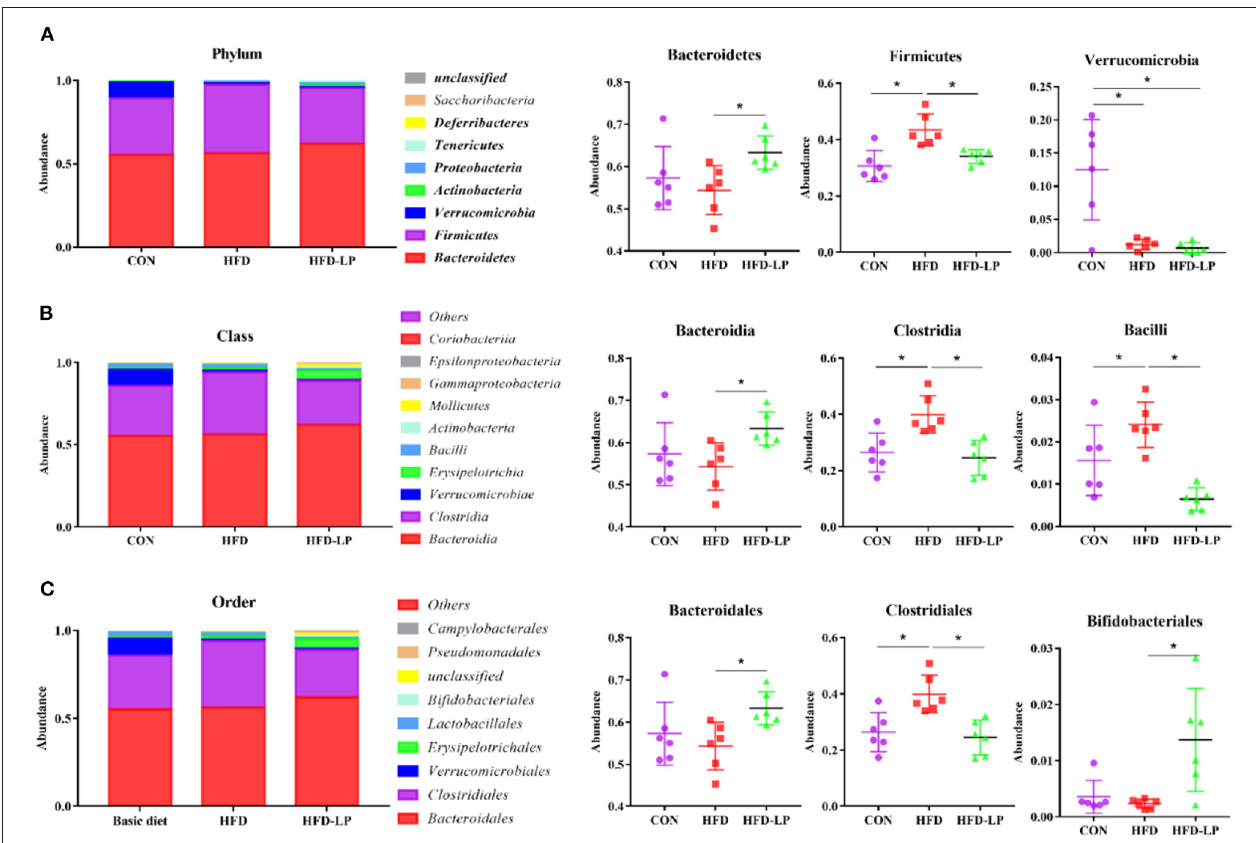
FIGURE 6 | Effect of Lactobacillus plantarum on the gut microflora in obese mice (A) Microorganism composition structure at phylum level and the specific percentages of Bacteroidetes , Firmicutes , and Verrucomicrobia ; (B) Microorganism composition structure at Class level and the specific percentages of Bacteroidia , Clostridia , and Bacilli ; (C) Microorganism composition structure at Order level and the specific percentages of Bacteroidales , Clostridiales , and Bifidobacteriales. Data are mean ± SD ( n = 6) and analyzed by one-way ANOVA. * p <